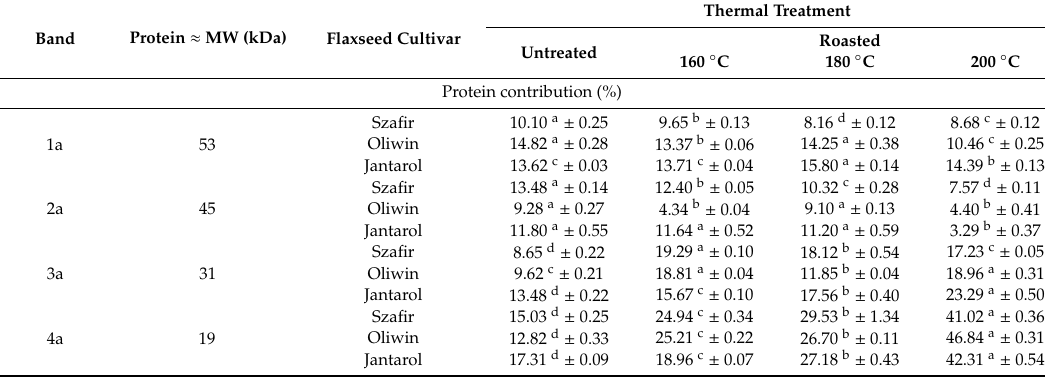
Table 1. The e ff ect of flaxseed roasting on changes in the protein profile of defatted meals—the SDS-PAGE under non-reducing